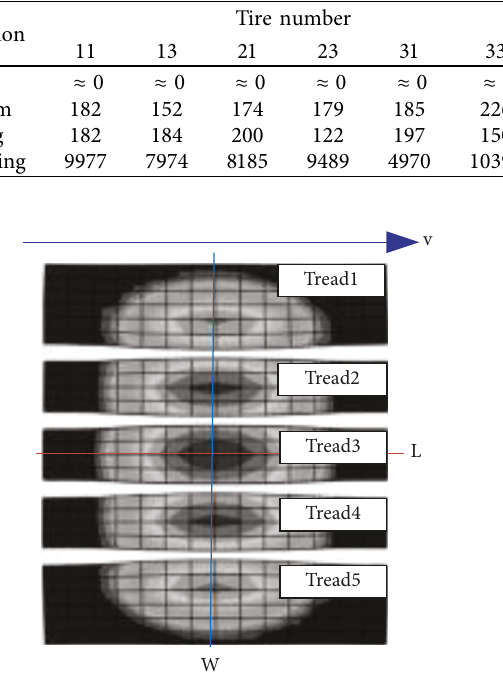
Figure 5: Schematic diagram of the contact area.